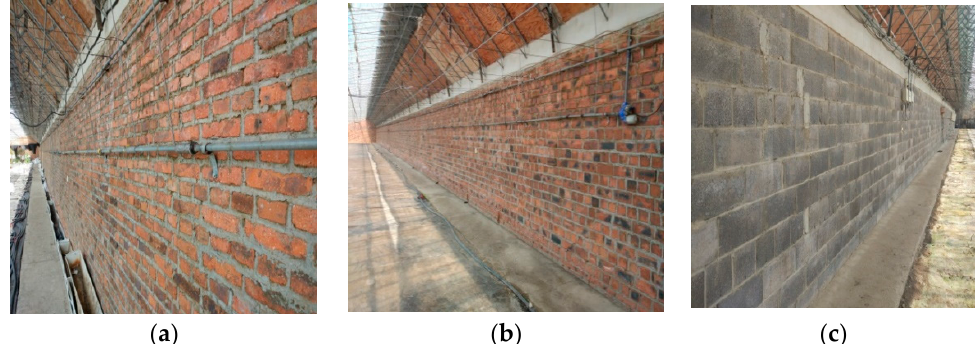
Figure 2. Average air temperature in Shenyang city (2014–2018), China.